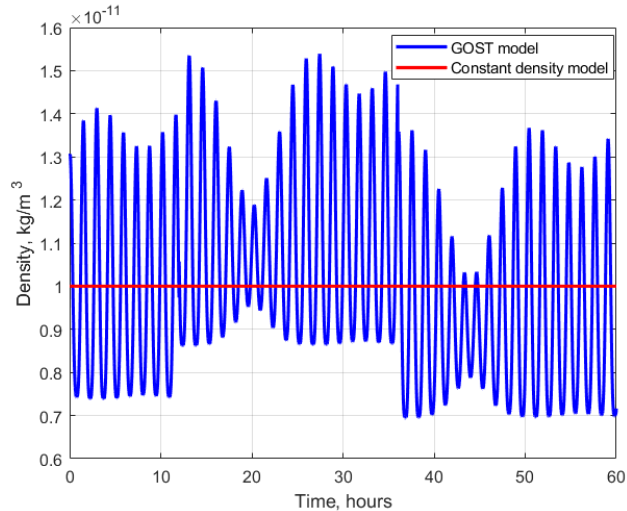
Figure 9. Atmosphere density according to the GOST model during the simulation.